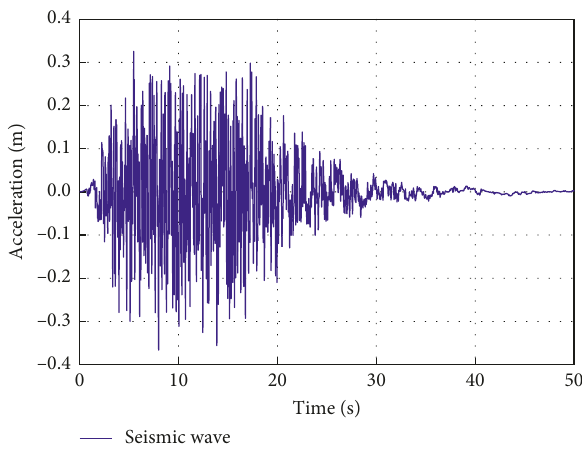
Figure 10: The 0.35g seismic wave.